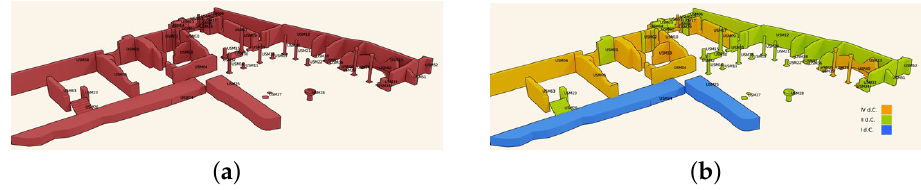
Figure 13. View of the remains of the complex from SW represented by means of proxy models. ( a ) proxies of the remains of the wall structures with EM color schema (see Table 3) ( b ) proxies of the remains of the wall structures with chronological phases color schema.